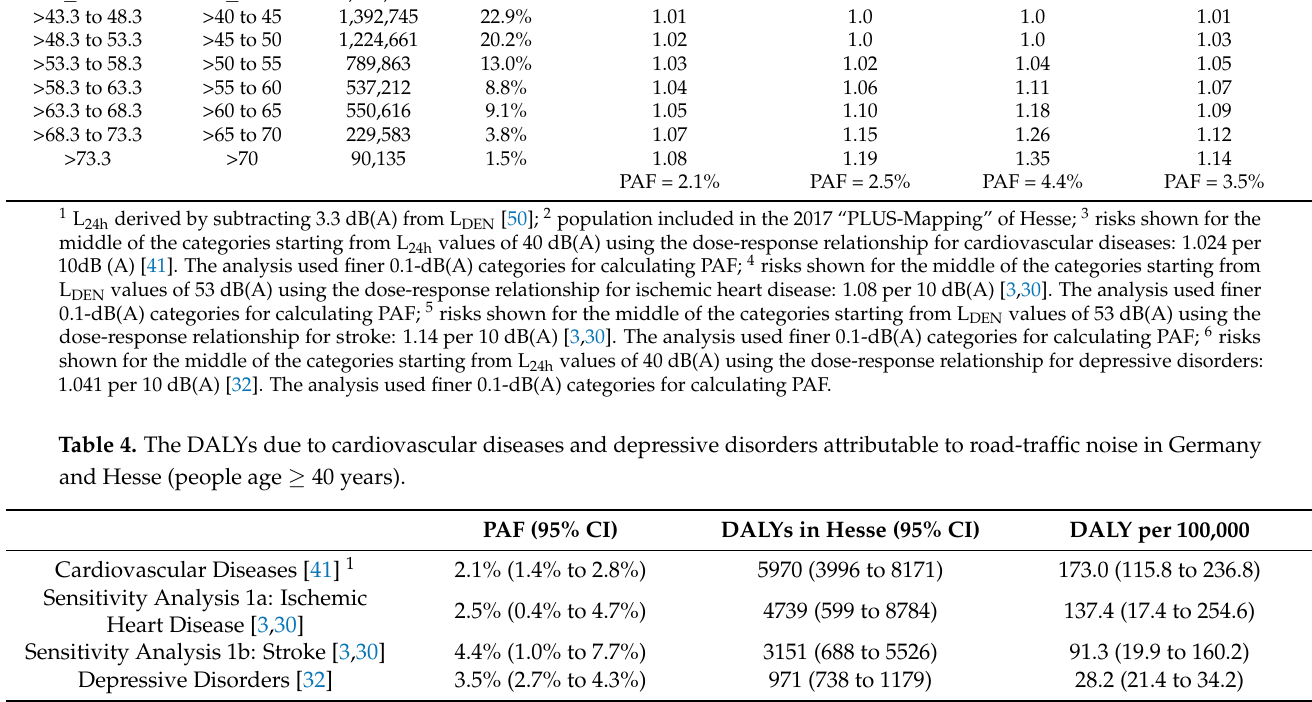
Table 3. Road-noise distribution in Hesse and the population-attributable fraction of cardiovascular diseases, ischemic heart disease, and depressive disorders for road-traffic noise. L DEN